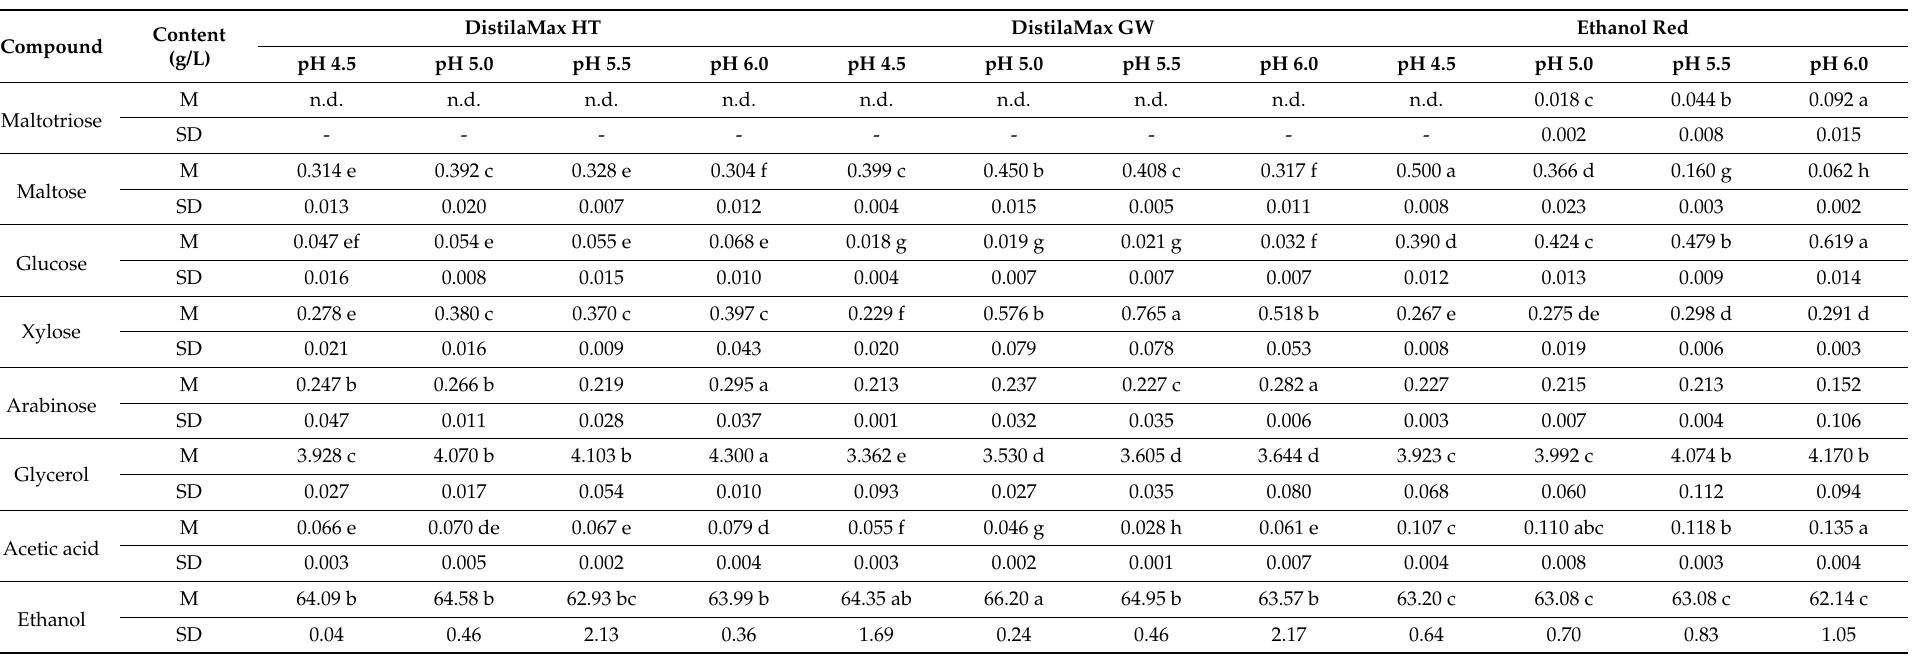
Table 2. Chemical composition of mashes prepared by the pressure-thermal method and fermented by various yeast